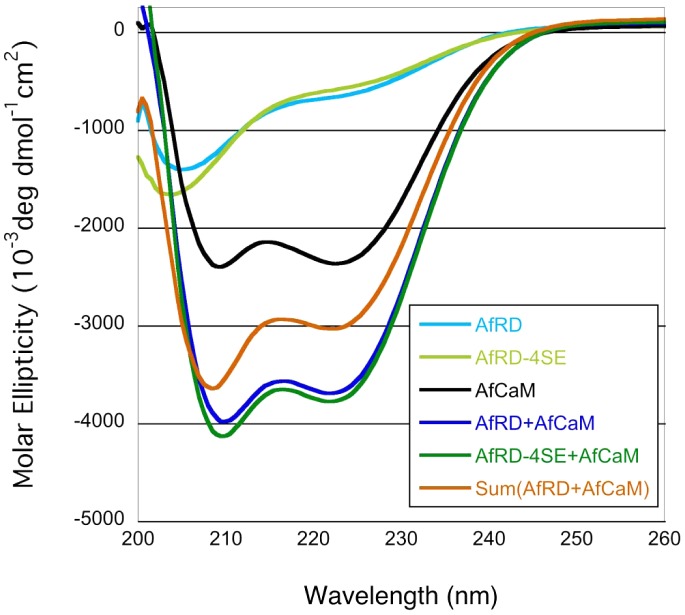
Phosphorylation at the Serine-Proline Rich Region does not influence changes in conformation following Ca2+/calmodulin binding.CD spectra collected at 20°C for AfRD and AfRD-4SE, AfCaM, and equimolar mixtures of AfCaM:AfRD and AfCaM:AfRD-4SE. Spectra for AfRD-4SE indicate they occupy similar disordered ensembles. Spectra for the AfCaM:AfRD and AfCaN:AfRD-4SE complexes demonstrate that the phospho-mimetic glutamates in AfRD-4SE do not perturb the secondary structure of the bound RD. Also shown is Sum (AfRD+AfCaM), which is the mathematical sum of the AfRD and AfCaM spectra. This is what would be obtained if the AfRD and AfCaM did not interact.